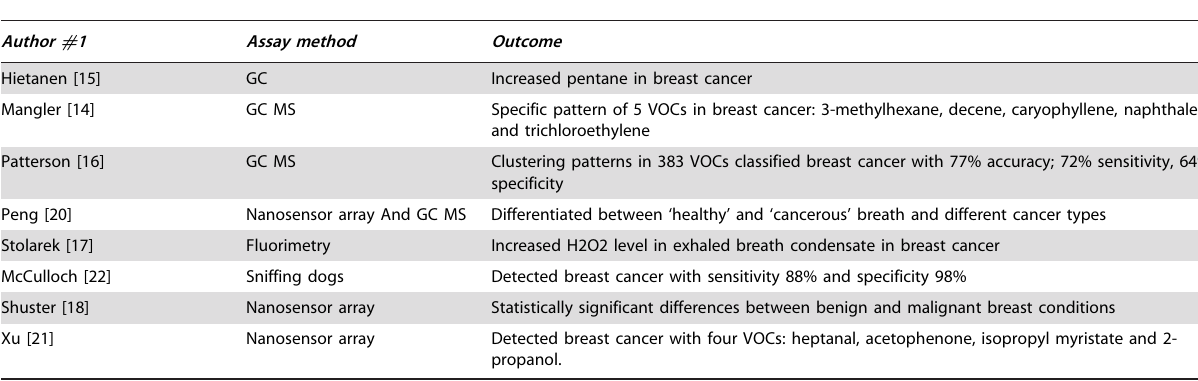
Table 3. Summary of previous reports by other investigators of breath biomarkers of breast